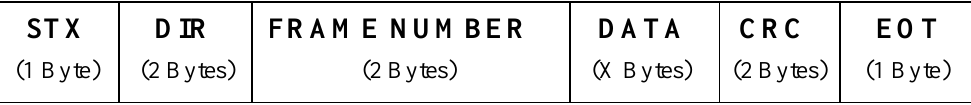
Figure 6. A communication frame structure.